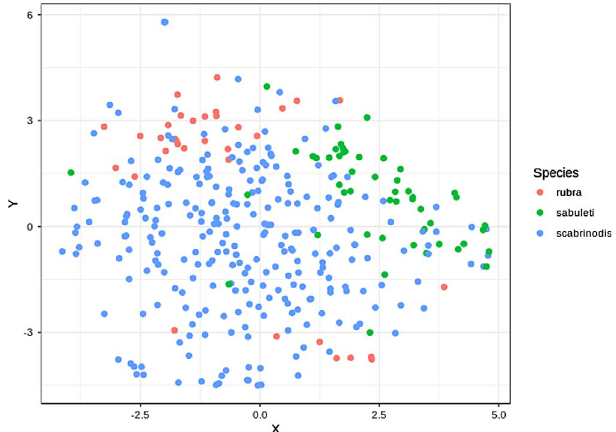
Figure 6. Visualisation of infection patterns based on relative thallus number on 16 body parts, using t-SNE to reduce the number of dimensions of the data set ( n = 354).